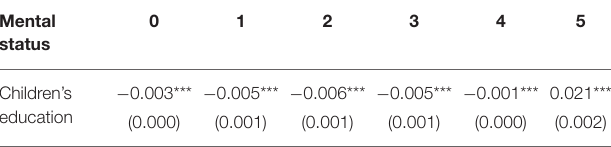
TABLE 3 | The marginal effects of benchmark regression model